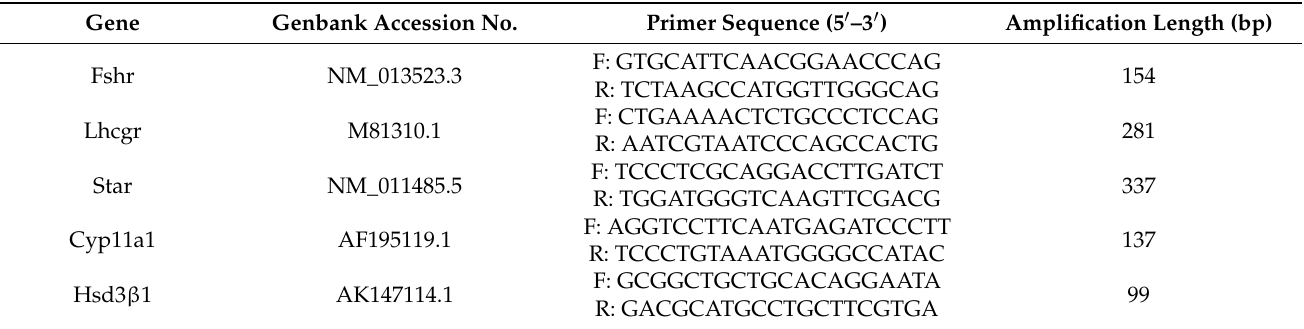
Table 1. qPCR Primer sequences for the tissue